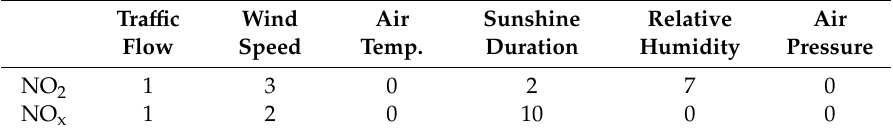
Table 2. Delays (h) of the variable received through the multi-objective optimization